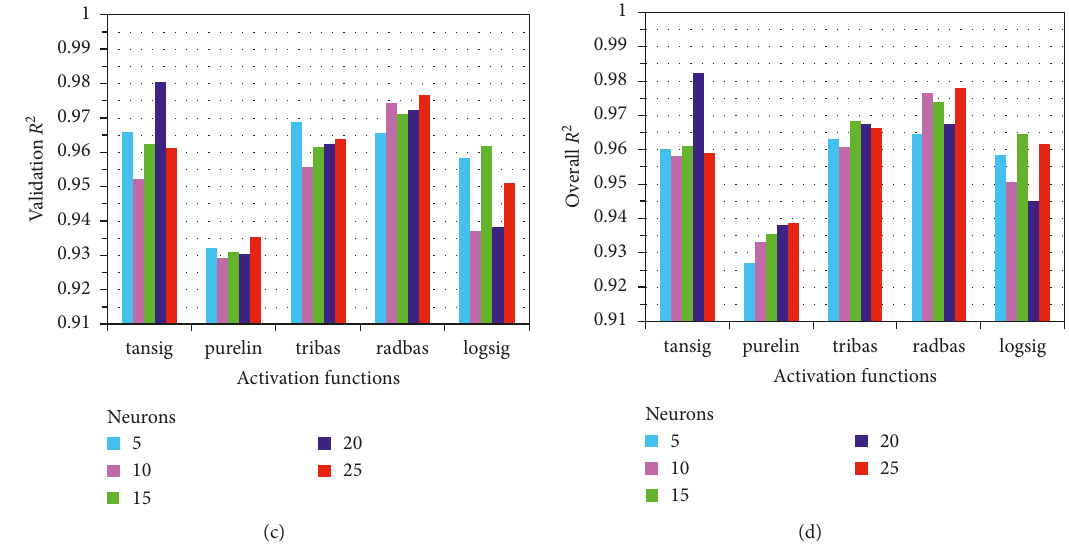
Figure 6: The coefficient of determination ( R 2 ) values for the prediction of specific heat.